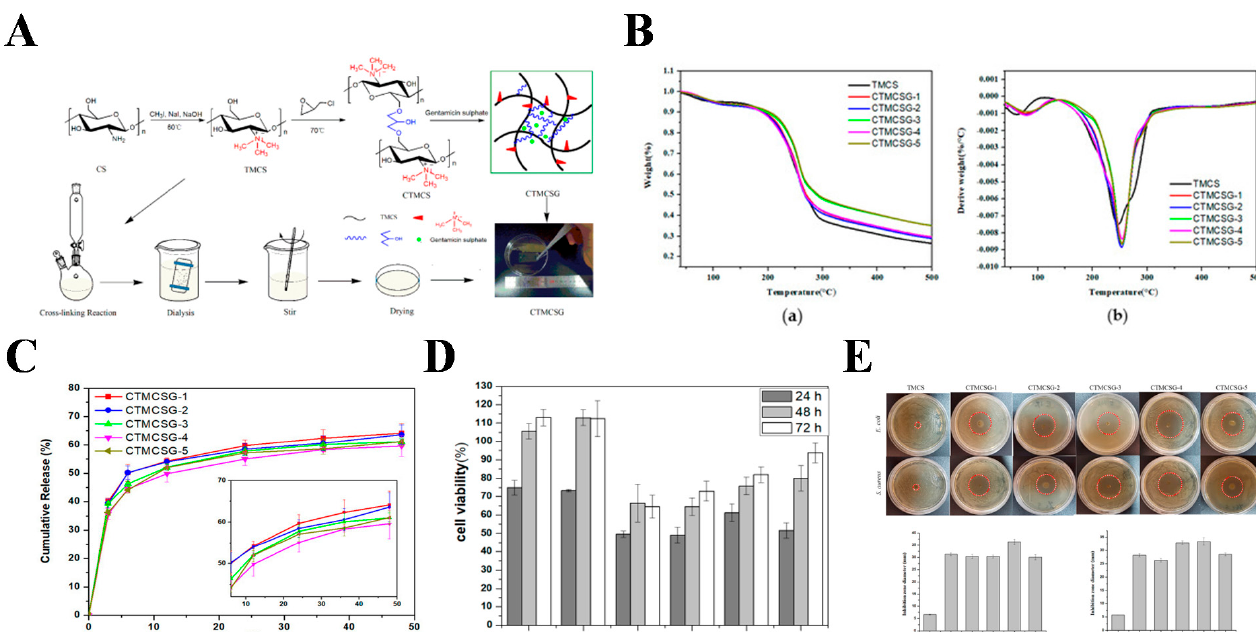
Figure 6. ( A ) Synthesis routes for chitosan hydrogel films; ( B ) thermal Analysis of TMCS film and CTMCSG hydrogel films. ( a ) TGA curves; ( b ) DTG curves; ( C ) the in vitro gentamicin sulfate release of CTMCSG hydrogel films; ( D ) the antibacterial activity of TMCS film and CTMCSG hydrogel films; ( E ) the cytotoxicity of TMCS film and CTMCSG hydrogel films. Reprinted with permission from Ref. [107]. Copyright 2021, MDPI.